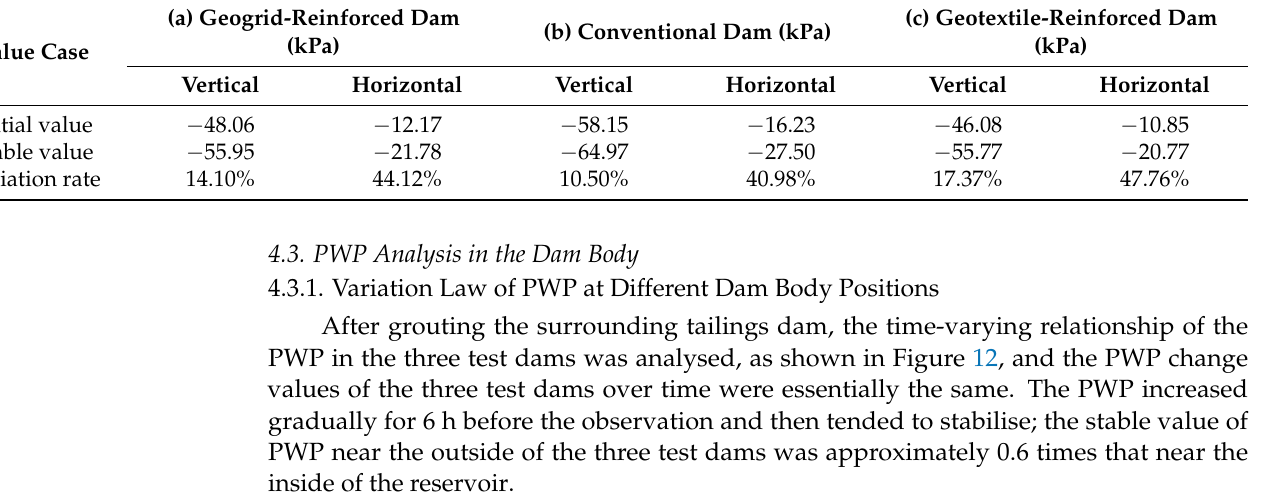
Table 4. Variation of IP in the dam body.